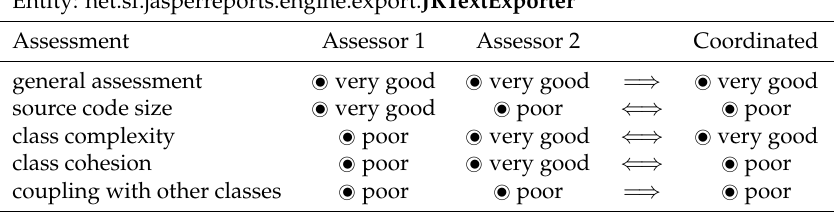
Table 2. An example of program entity assessment and coordination.